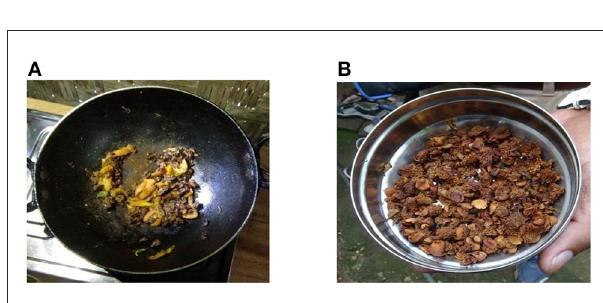
FIGURE3 Seasonal foods: (A) Cooked tea flower. (B) Raw (preserved) tea